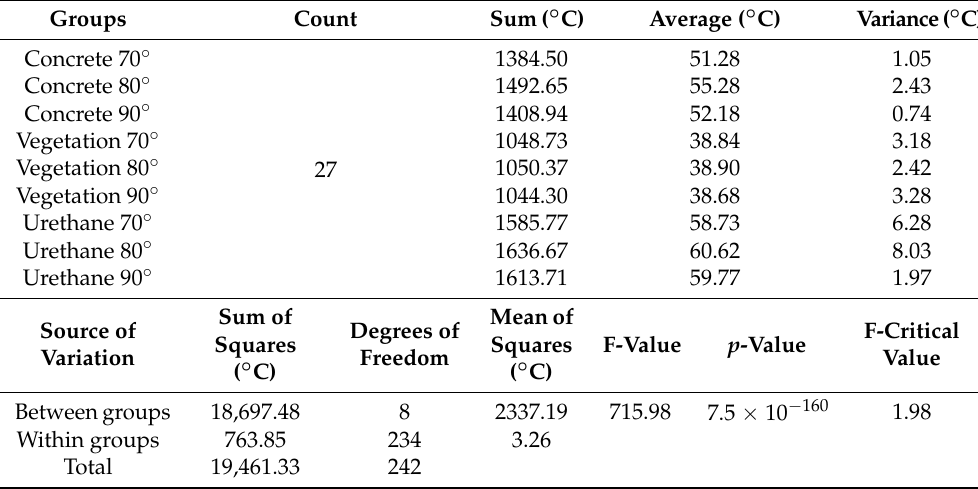
Table 9. ANOVA test to compare the difference in LST for each land cover according to the angle in study area